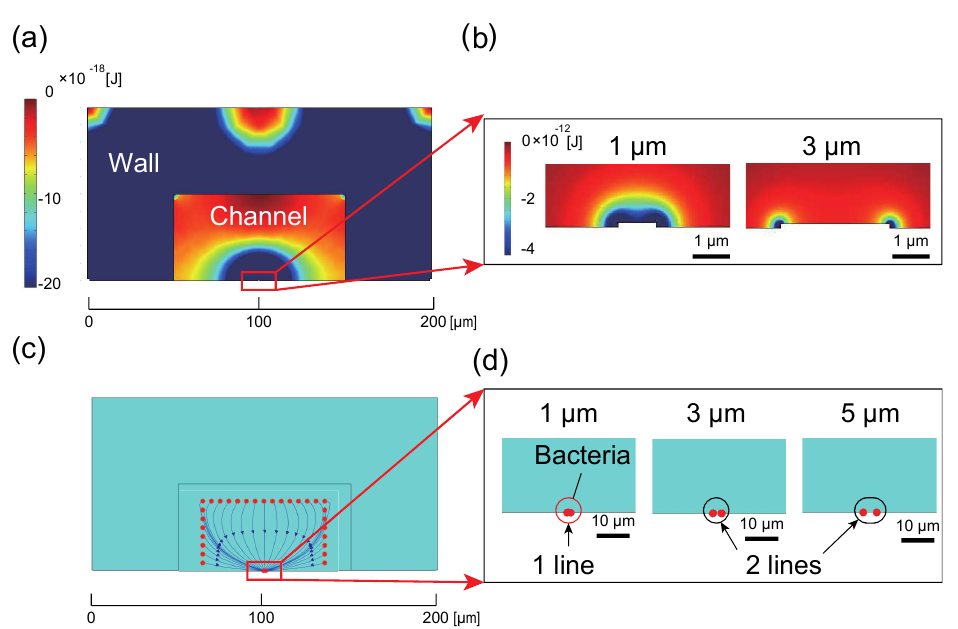
Figure 5. Analysis results: ( a ) the potential energy of the dielectrophoretic force in the cross section of the microchannel, ( b ) an enlarged view of the vicinity of the capture electrode, ( c ) the trajectory of particle tracing, and ( d ) a view of the capture results for each electrode width. Poor contrast between the particles, background, and electrode made it difficult to distinguish these components, and thus, the background was dyed light blue.